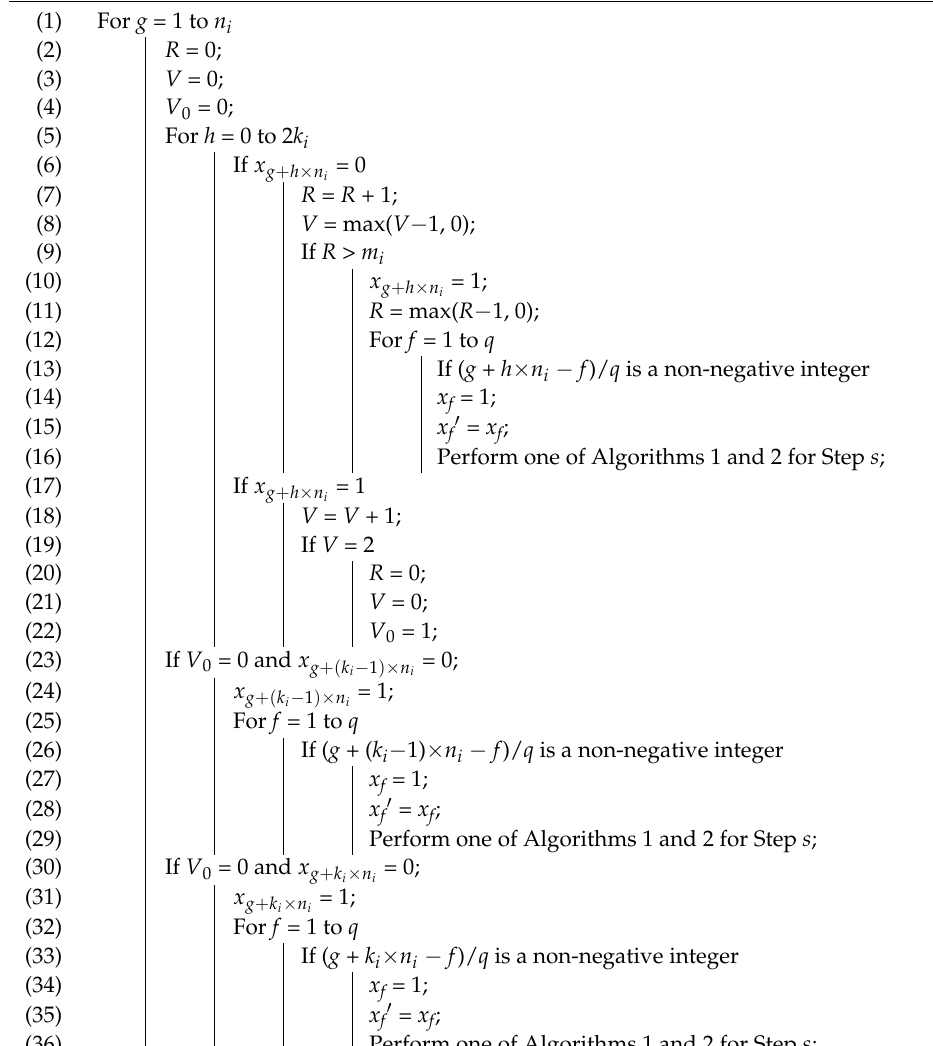
Algorithm 5: Individual modification for the case with d i =